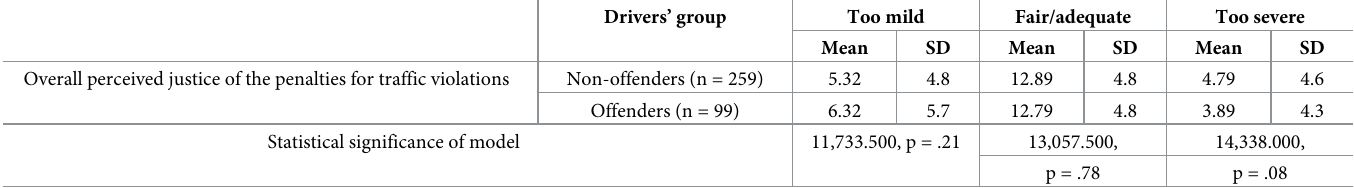
Table 5. Comparison of the perceived penalties justice in general scale between offenders and